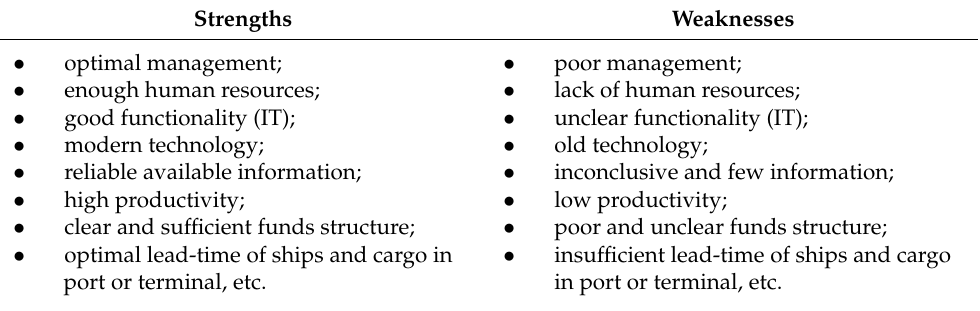
Table 1. SWOT analysis of the digitalization level of ports or